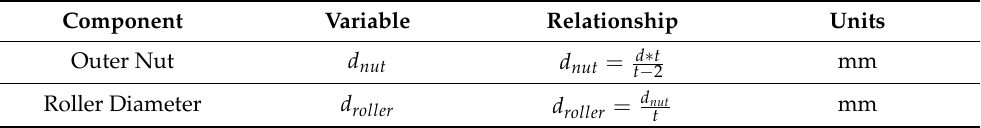
Table 2. Resulting functional variables from primary